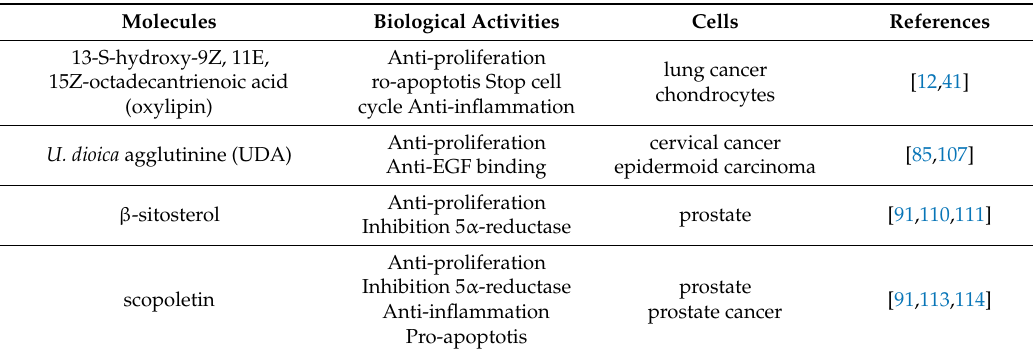
Table 3. Biological activities of specific molecules isolated from U. dioica .